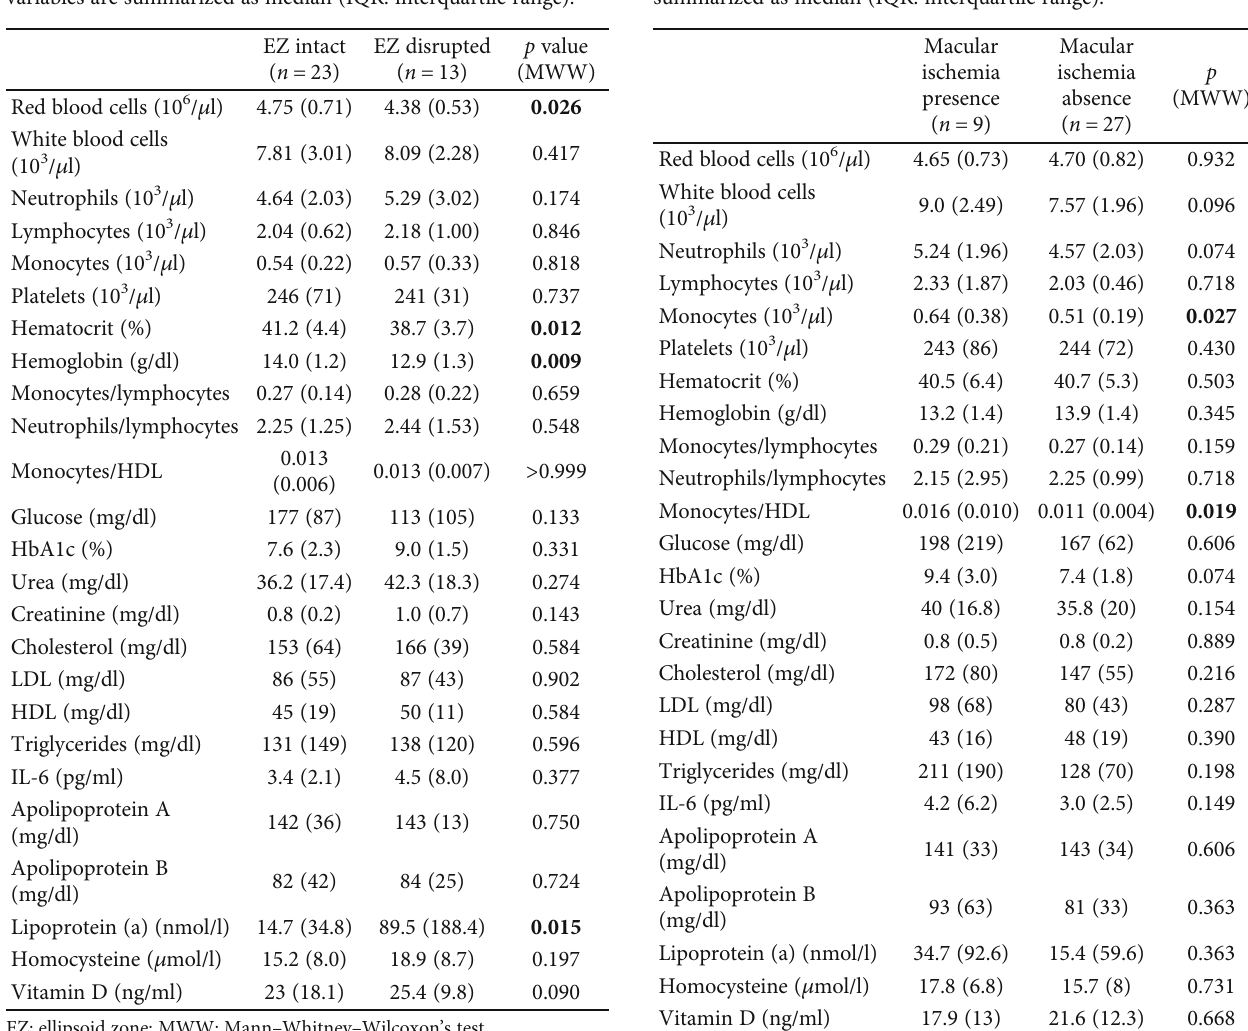
Table 4: Association between laboratory variables and macular ischemia on fl uorescein angiography. Laboratory variables are summarized as median (IQR: interquartile range).